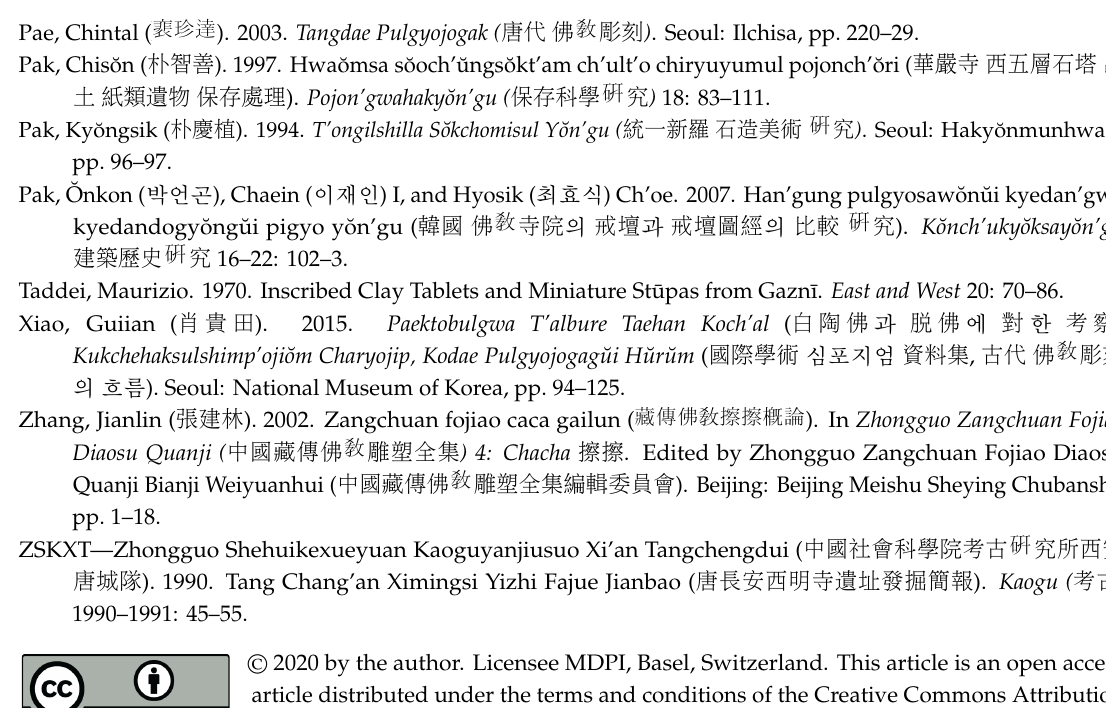
Figure 20. Clay Buddha, Pagan period, 12th–13th centuries, 9.6 × 7.1 cm, Myanmar [Source: (Fukuoka Art Museum 2008, cover picture)].